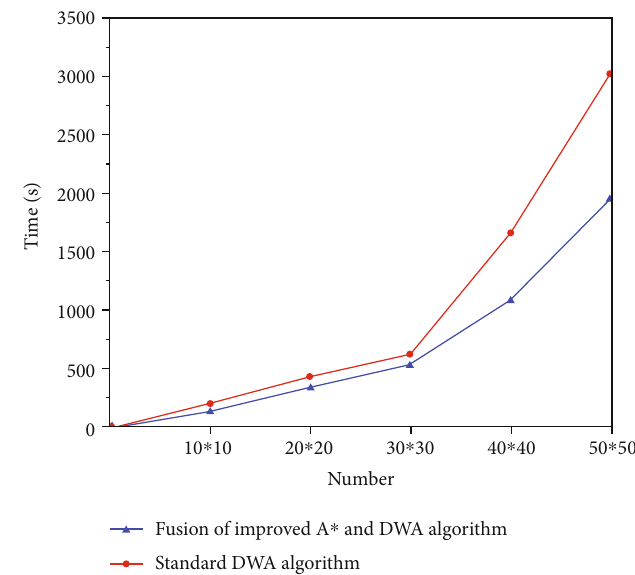
Figure 13: The relationship between the map size and the planning time planning of the two